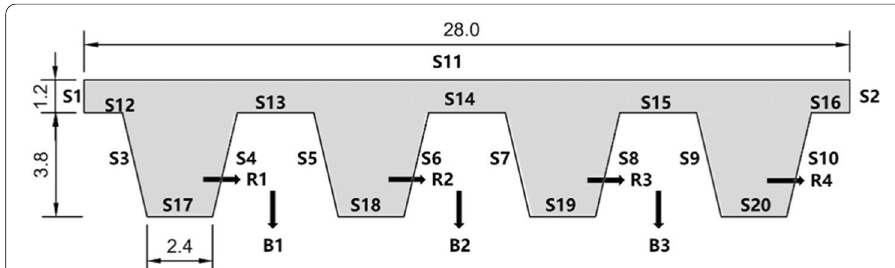
Fig. 8 Cross-section of the box-girder, and the girder surface is decomposed into panels named in the form of “SN”. The ribs and chambers are named in the form of “RN” and “BN” respectively. In which “N” is the number of the panel, rib or chamber. (unit: cm)